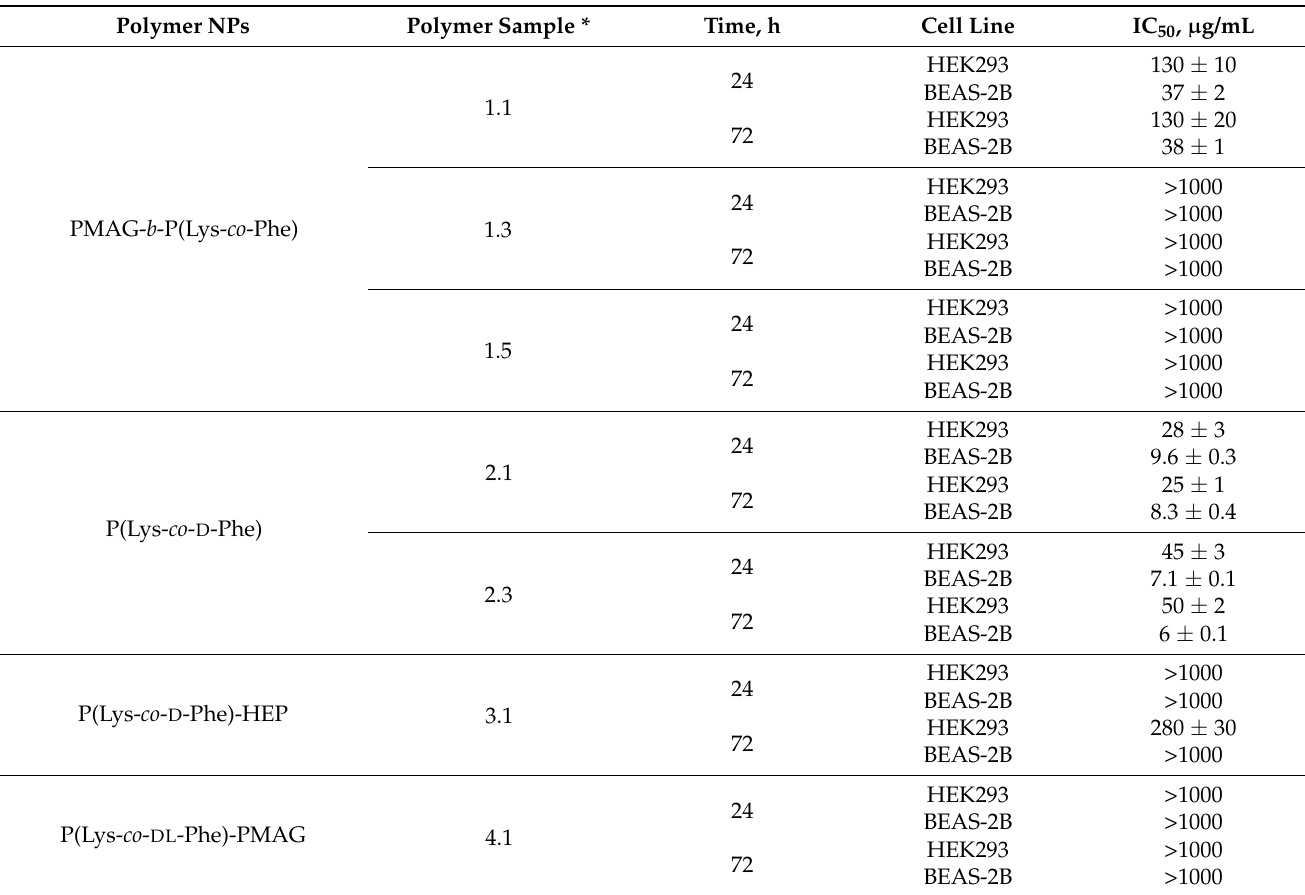
Table 3. Cytotoxic effect of developed nanoparticles. Polymer NPs Polymer Sample